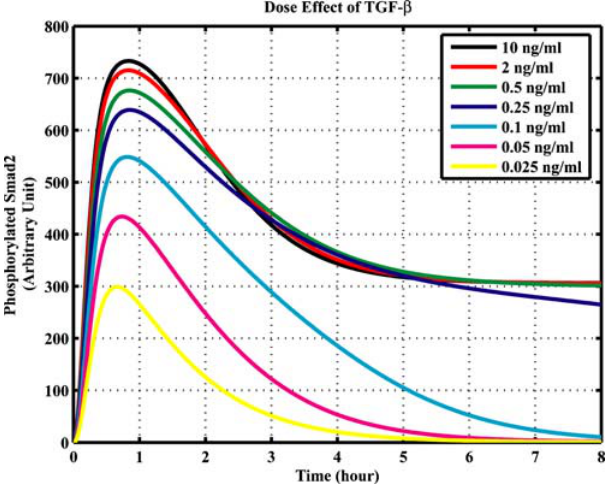
Figure 3. Effects on Smad2 phosphorylation by different doses of TGF- b .